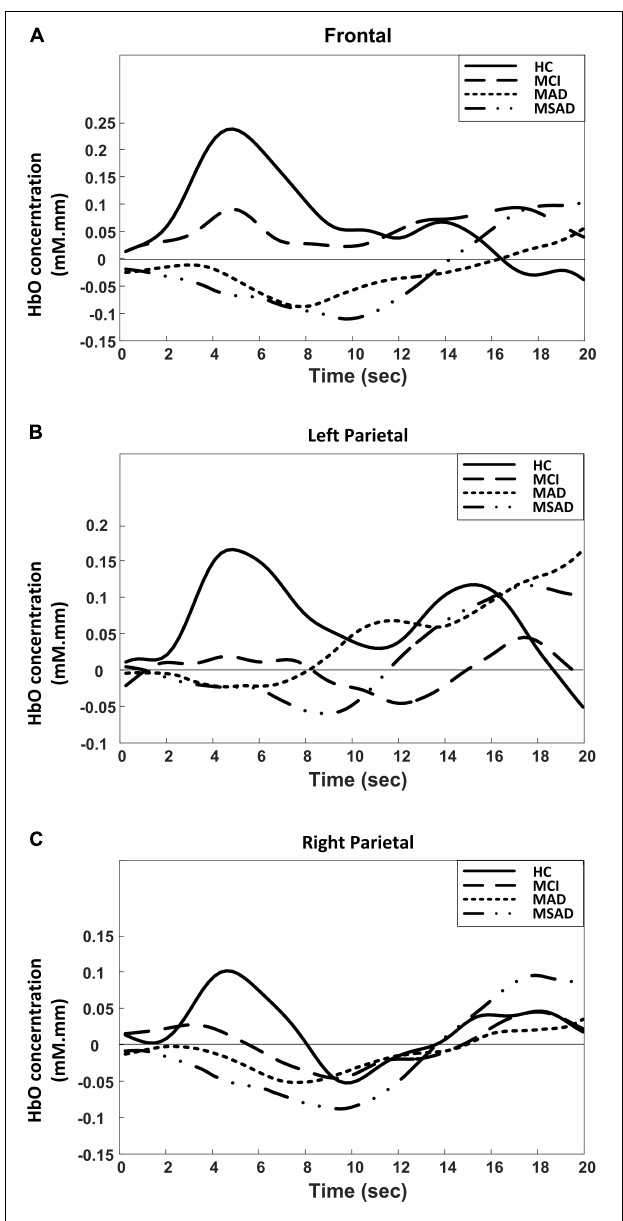
FIGURE 4 | Group-averaged changes of HbO concentration for all participants in three brain regions during encoding task. (A) Frontal area; (B) Left parietal; (C) Right